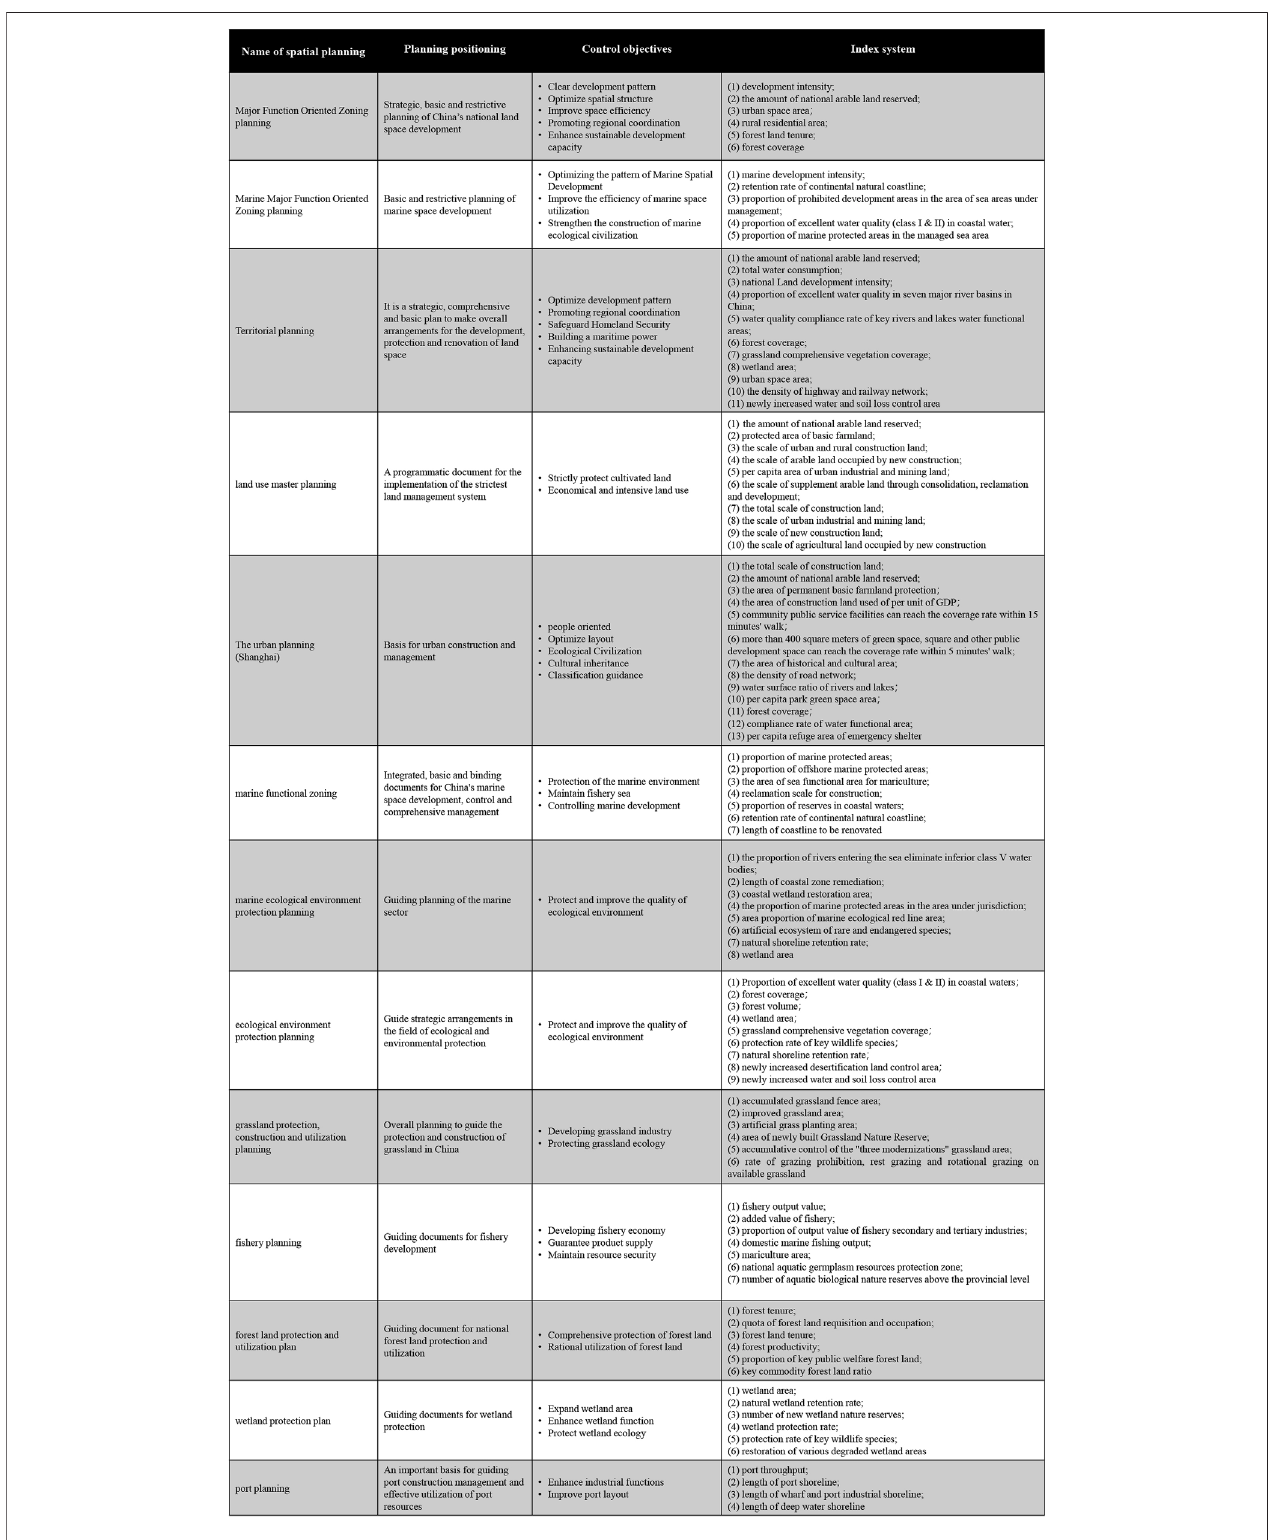
FIGURE 2 | China ’ s existing spatial planning index system.